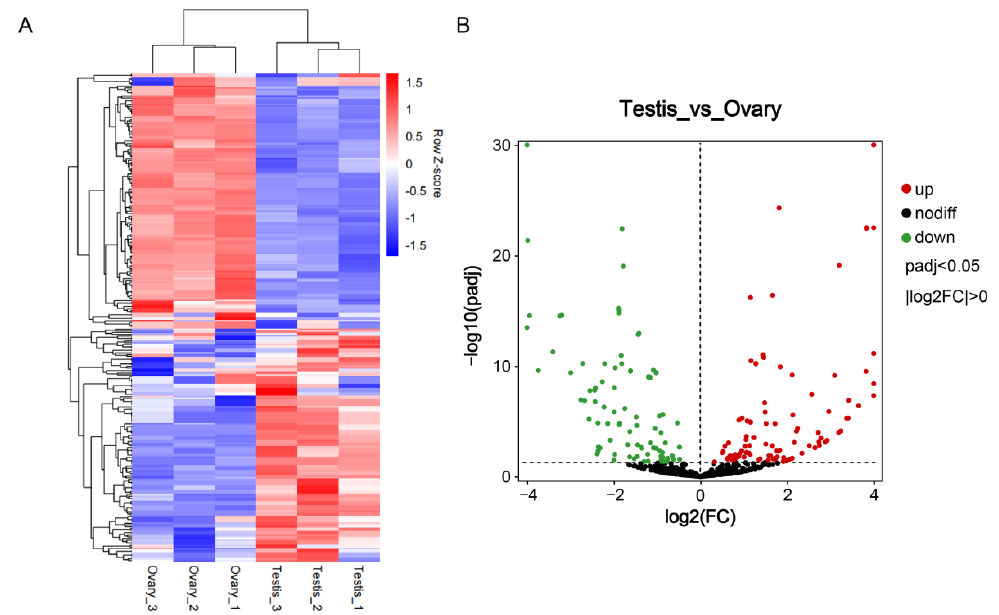
Figure 2. ( A ): Heatmap of all miRNA (DEMs) differentially expressed between the ovary and testis groups. Red represents highly expressed miRNAs and blue represents minimally expressed miRNAs. ( B ): Volcano plot of the miRNAs in the ovary and testis groups.